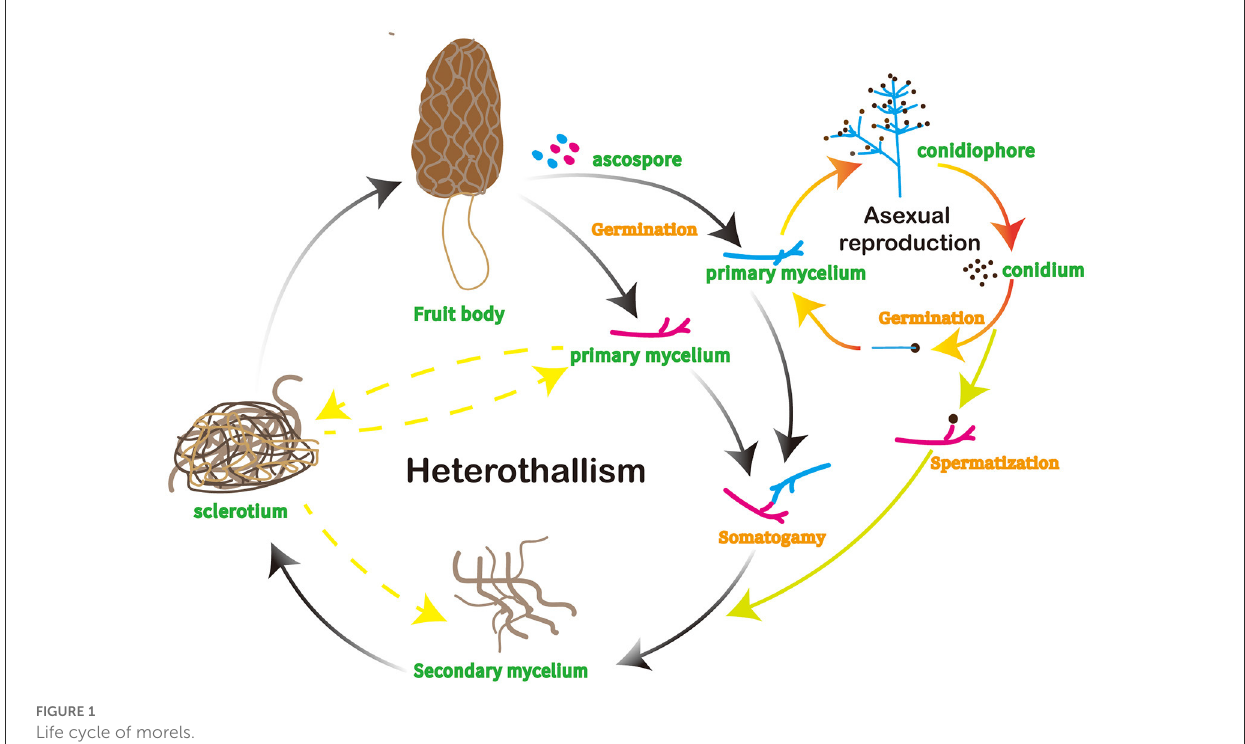
FIGURE1 Life cycle of morels.